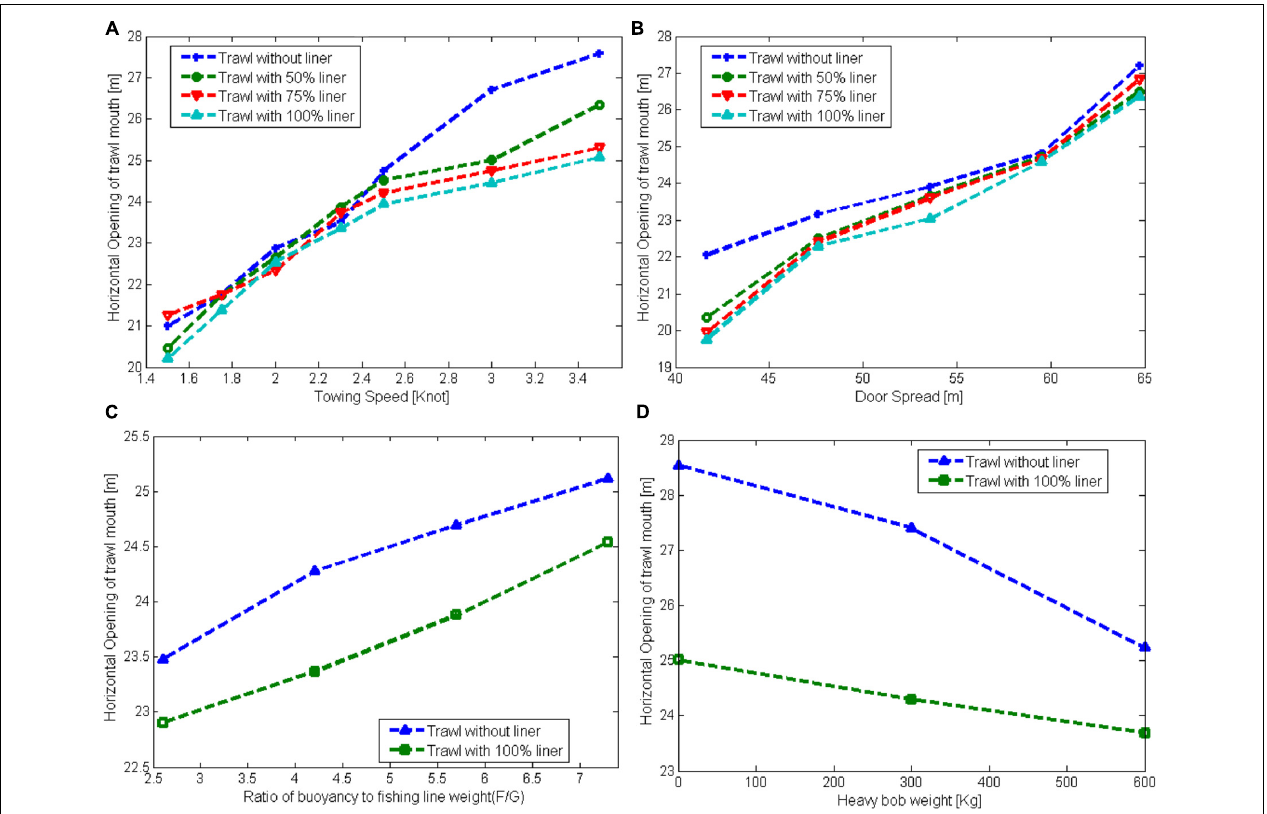
FIGURE 7 | The horizontal diameter of the elliptical trawl net mouth shape of different trawls about the (A) towing speed, (B) door spread, (C) ratio of buoyancy to F / G , and (D) heavy bob weight: current data estimated with 95% confidence intervals from the statistical analysis.